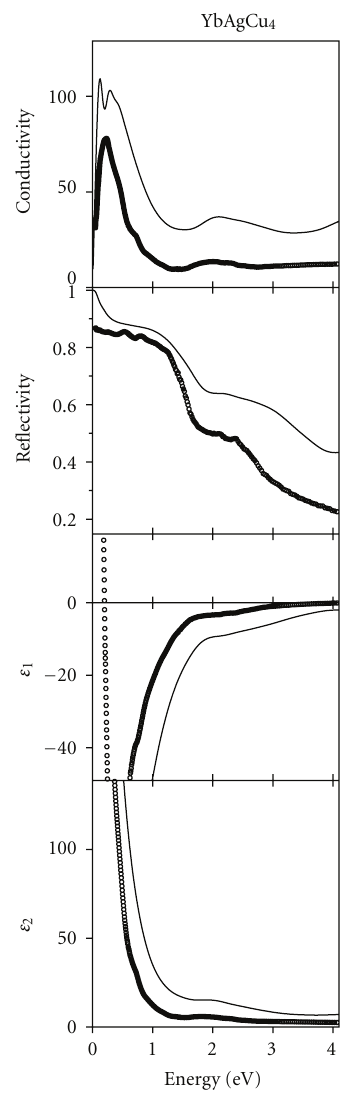
Figure 102: Comparison between the experimental (dots) and LSDA+ U calculated (solid line) optical spectra of YbAgCu 4